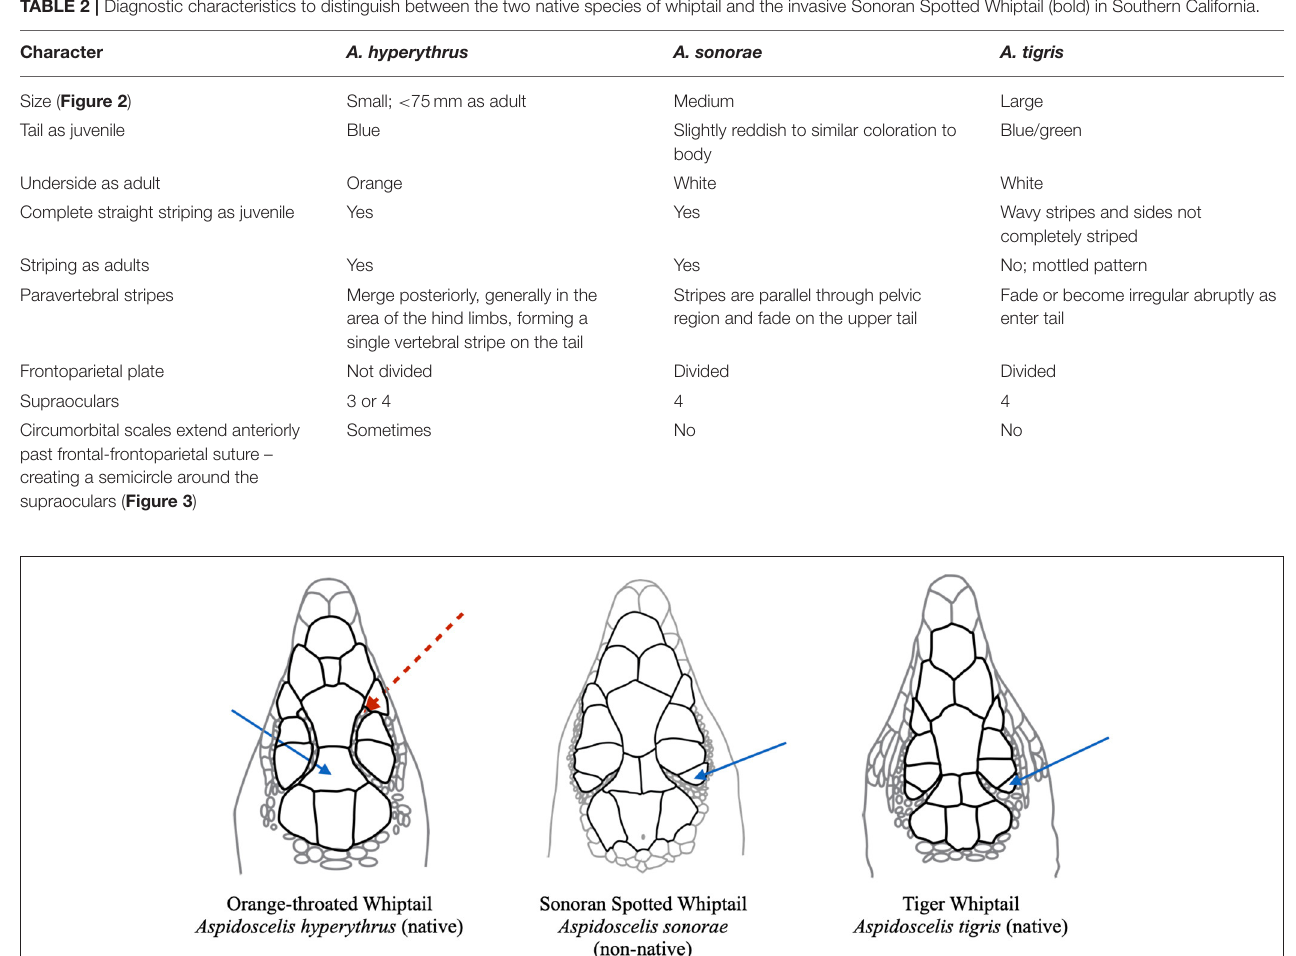
FIGURE 3 | Left is a head drawing of Aspidoscelis hyperythrus , middle is A. sonorae , and right is A. tigris . Blue arrow on left shows the non-divided frontoparietal that is diagnostic of A. hyperythrus . Blue arrows on middle and right drawings show additional supraocular scale that is sometimes absent from A. hyperythrus . The circumorbital scales are the small scales between the supraocular scales and the frontoparietal scale. Only in A. hyperythrus do the circumorbital scales sometimes extend forward of the frontal-frontoparietal suture (dashed red arrow in left